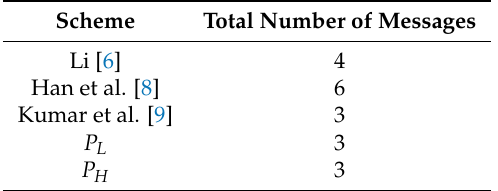
Table 2. Comparison of total number of exchanged